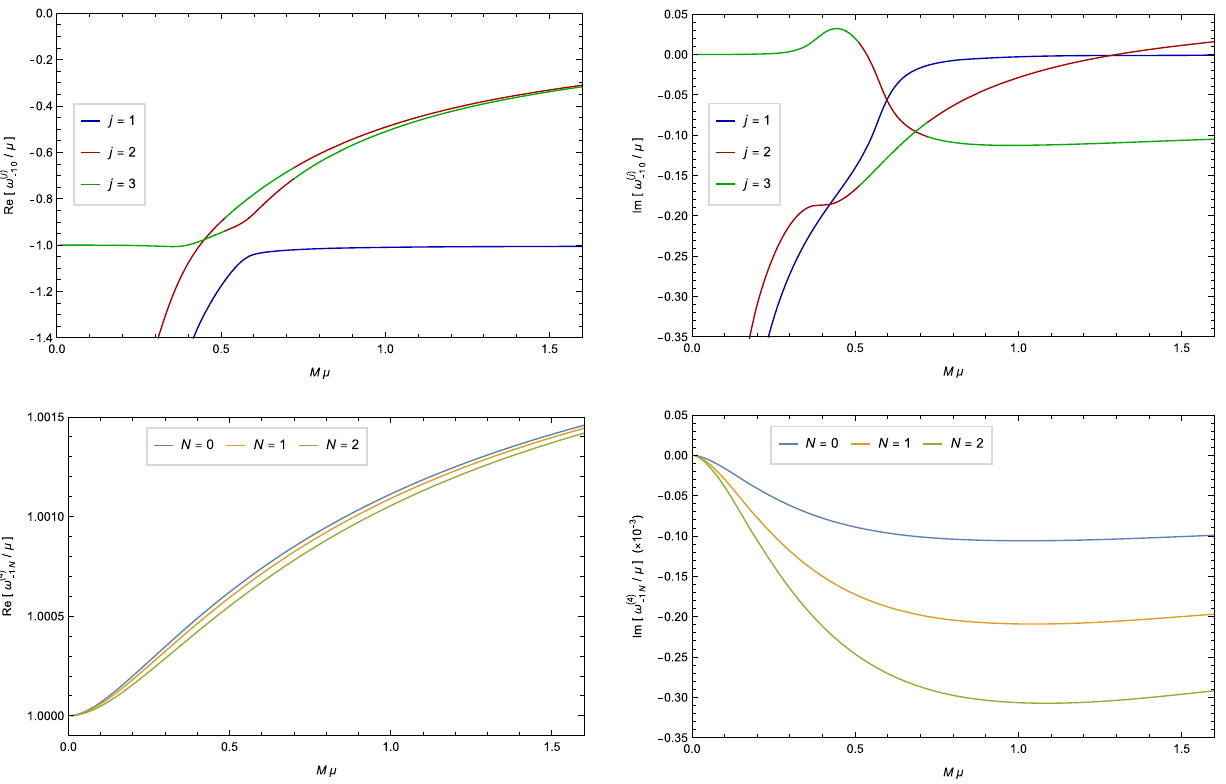
Fig. 2 Massive scalar resonant frequencies in the Kerr black hole spacetime for m = − 1, and a = 0 . 99. The left plots show the oscillation ( j ) /μ ] , while the right plots show the decay (or growth) rate Im [ ω ( j ) frequency Re [ ω mN